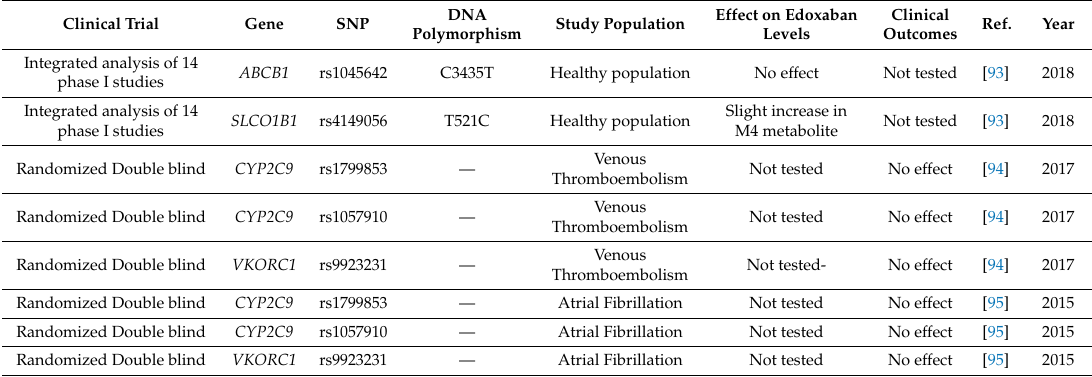
Table 5. Pharmacogenomic studies of